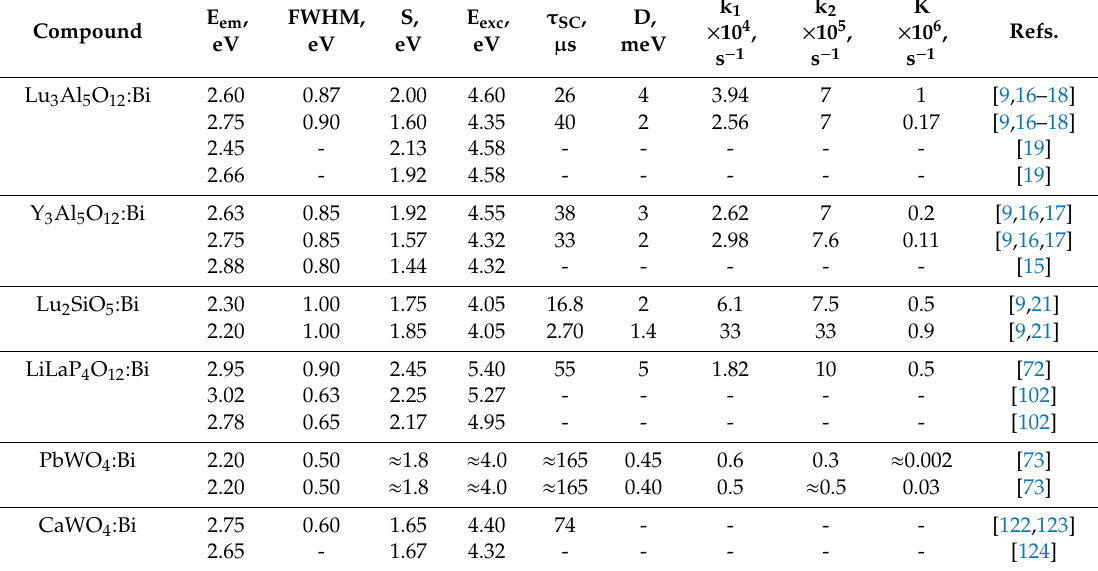
Table 2. Emission peak positions (E em ), full widths at half maxima (FWHM), the Stokes shifts (S), positions of the lowest-energy excitation band (E exc ) and decay times ( τ SC ) of the slow decay component obtained at LHeT for the lower-energy triplet emission of Bi 3 + -doped compounds (denoted in this work the VIS emission). The parameters of the triplet RES: the spin-orbit splitting energy (D), the probabilities of the radiative decay of the metastable (k 1 ) and emitting (k 2 ) levels of the triplet RES, and the zero-temperature nonradiative transition rate (K) between the metastable and emitting levels.